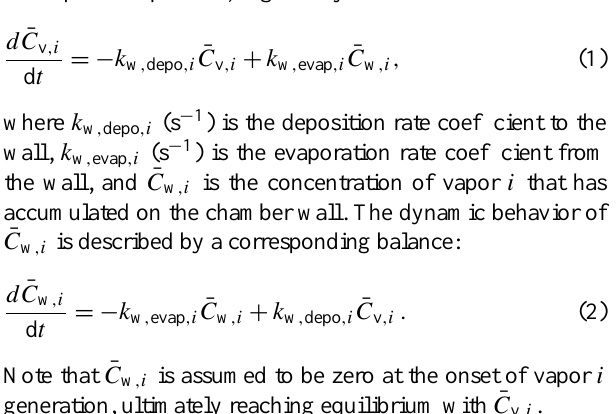
nopinone and pinanediol on the wall of a 4 m 3 FEP Teflon chamber are on average 0.4 and 0.8,